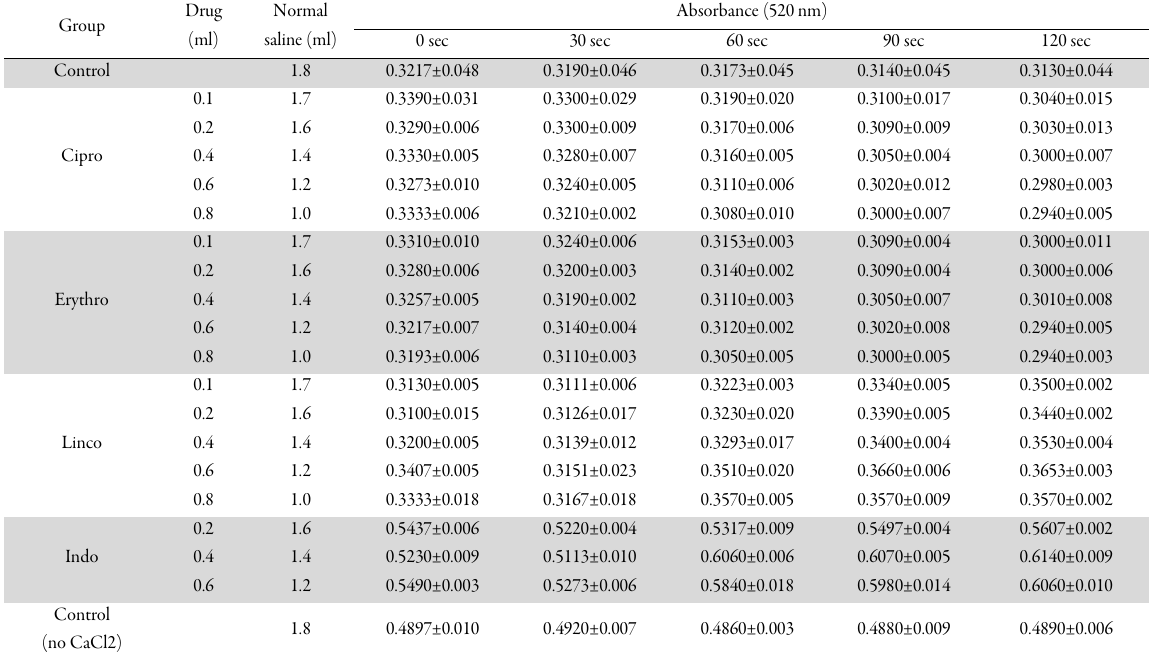
Table 8. Effect of the various antibiotics on platelet aggregation (comparative)